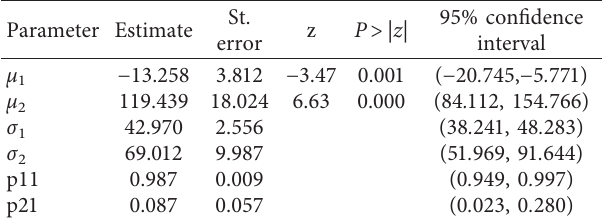
Table 5: Markov switching regression in means and standard deviations for the US BBB portfolio hedged by shorting UST. Parameter Estimate